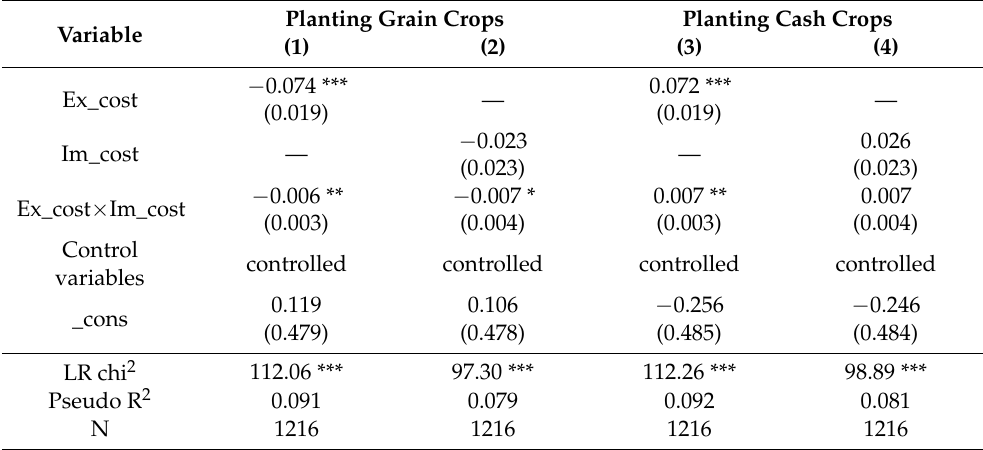
Table 6. Interaction of the two types of land costs. Planting Grain Variable